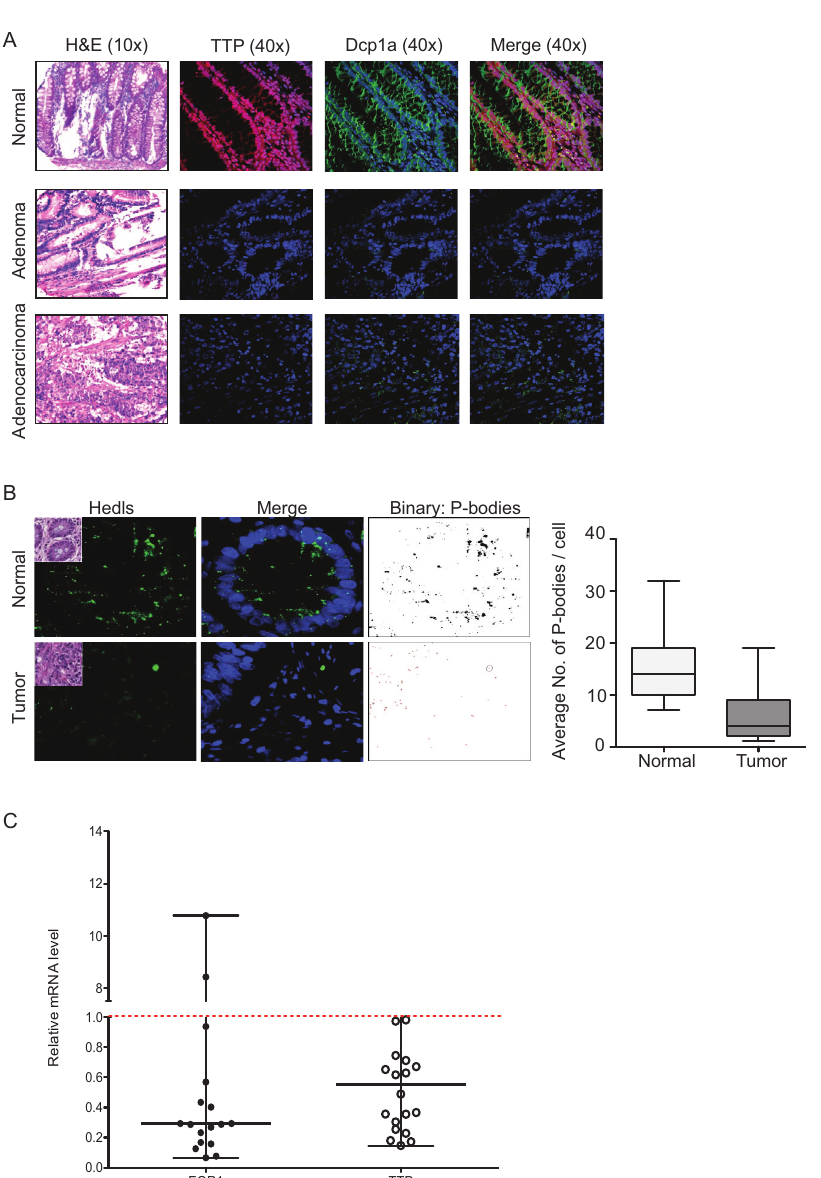
Figure 11. TTP loss in tumor tissue correlates with P-bodies loss and EGR1 downregulation. ( A ) Hematoxylin/eosin staining and immunofluorescence of TTP, Dcp1a on normal human colon tissue, adenoma, and adenocarcinoma. Staining shown is representative of CRC tissue array samples described in Experimental Section. ( B ) Immunofluorescence staining of P-bodies in normal colon and tumor tissue, using anti-Hedls antibody. P-bodies were quantified by ImageJ software by using images obtained from 14 normal and 20 tumor samples and quantitated in binary mode. ( C ) Expression of EGR1 ( n = 17) and TTP ( n = 18) mRNA was examined in total RNA isolated from human colon tumors and normal colon tissue by qPCR. GAPDH was used as a loading control. Relative EGR1 and TTP expression levels for tumors were normalized to their respective matched normal